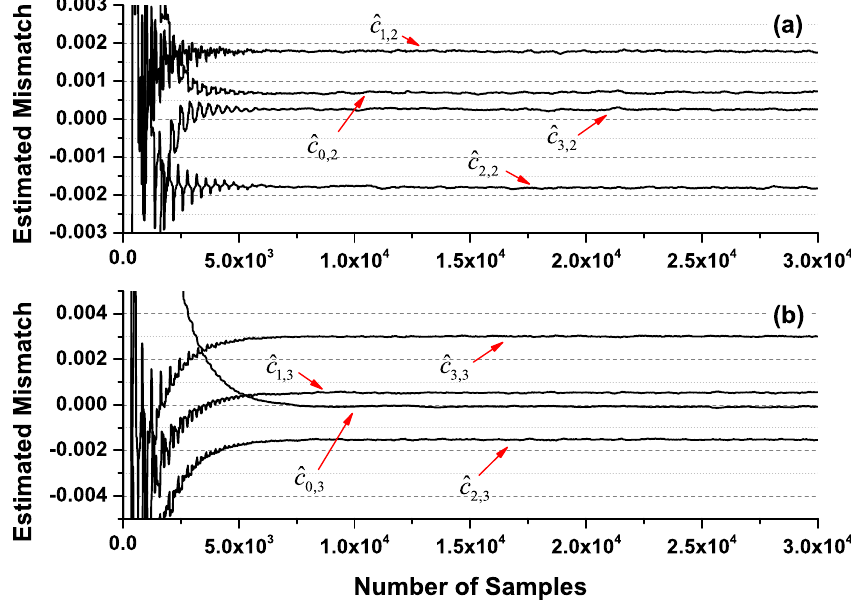
Figure 8. The convergence behavior of the estimated parameters ˆ c k , l [ n ] . ( a ) Second order nonlinear parameters; ( b ) third order nonlinear parameters.